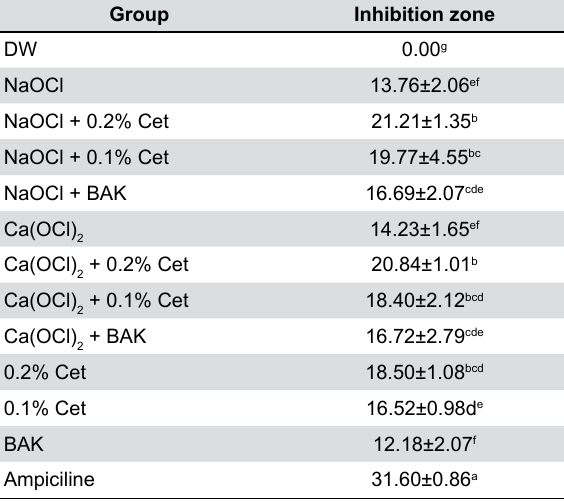
Different letters indicate statistical difference between solutions ANOVA (Tukey post hoc )